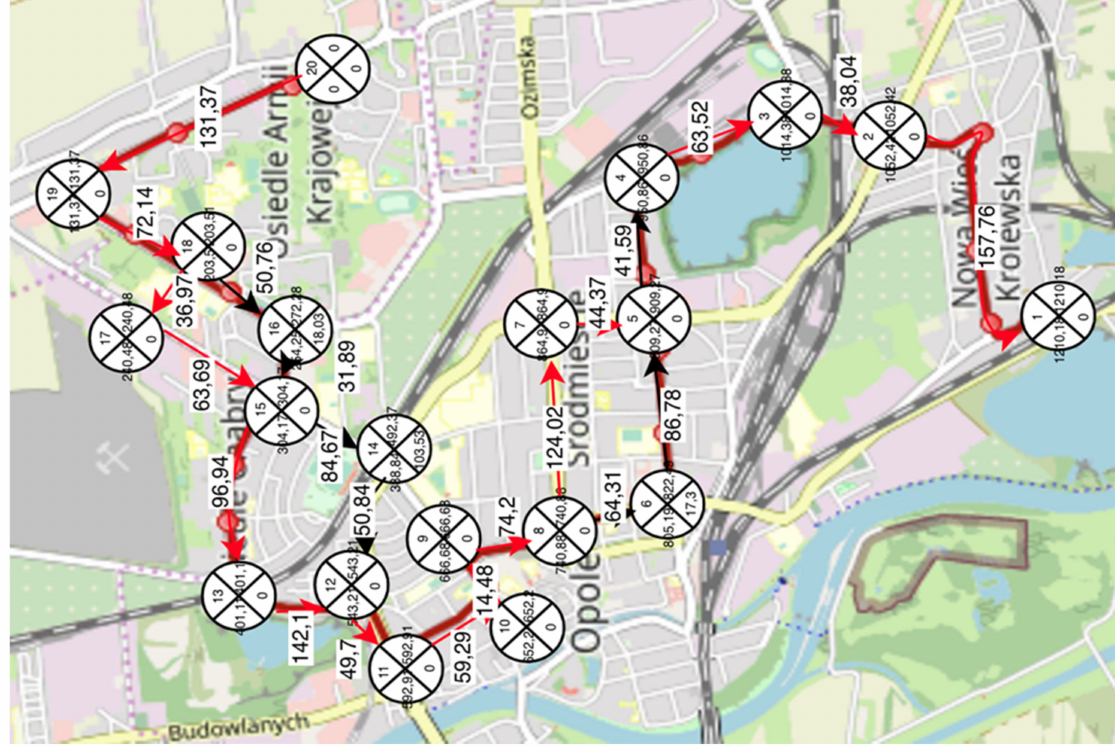
Figure 9. Critical path made for bus line no. 3 in